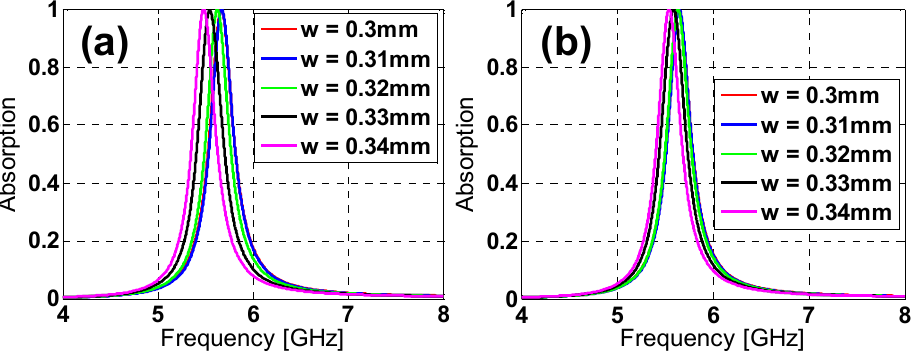
Figure 9. Star design absorption results in the simulation for different lengths of w for both ( a ) TE and ( b ) TM